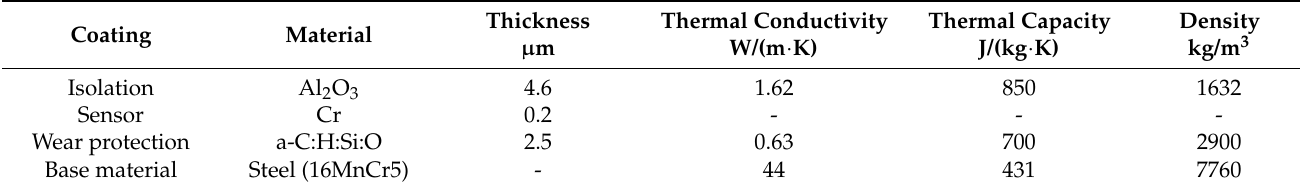
Table 3. Thermal material properties.